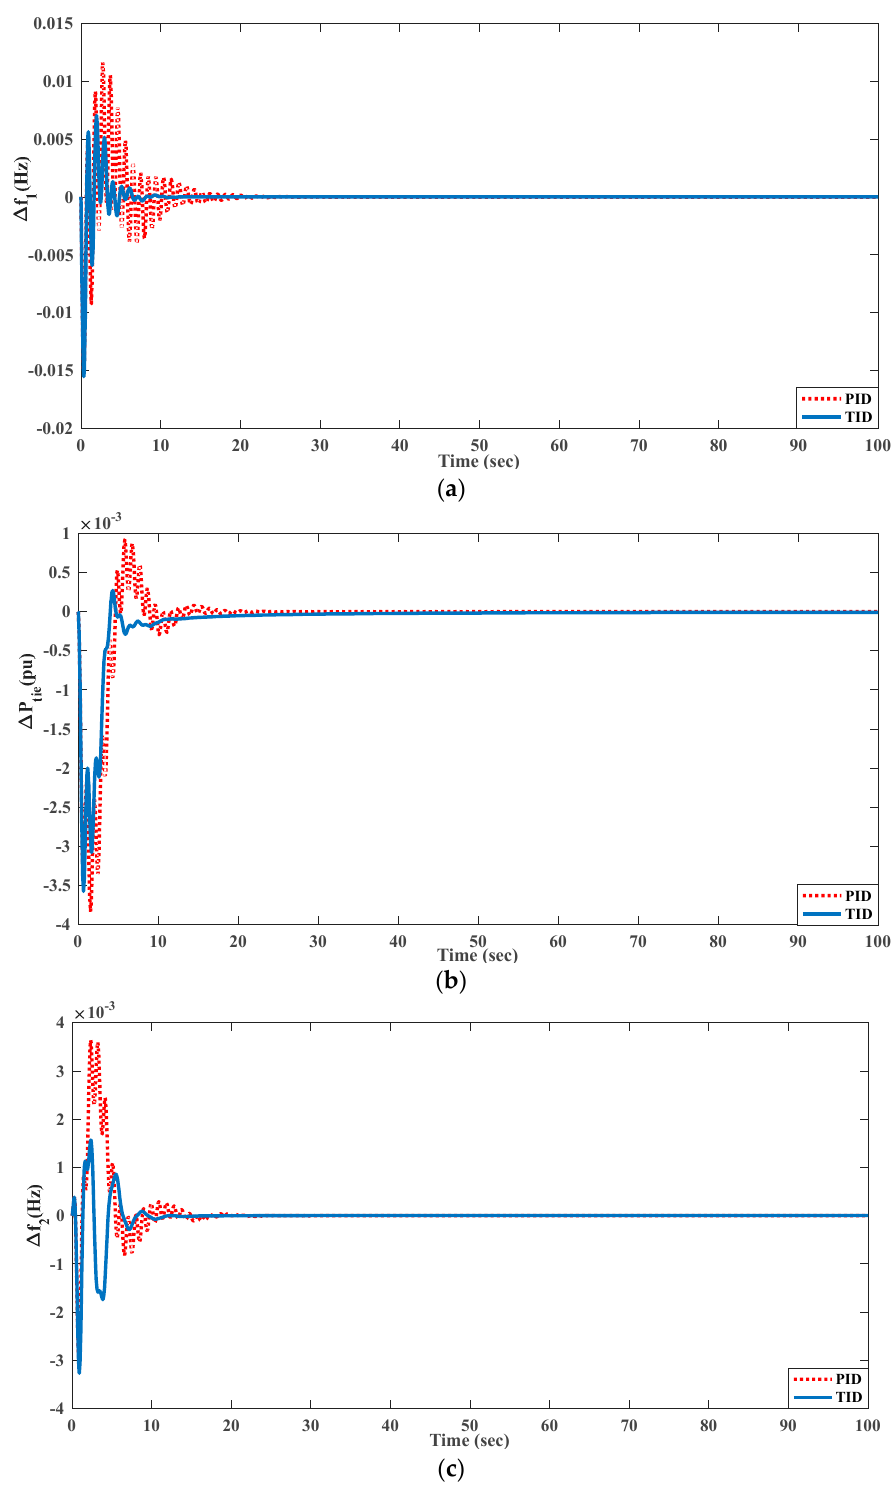
∆ P ∆ f 1 ; ( b ) tie; ( c ) 2